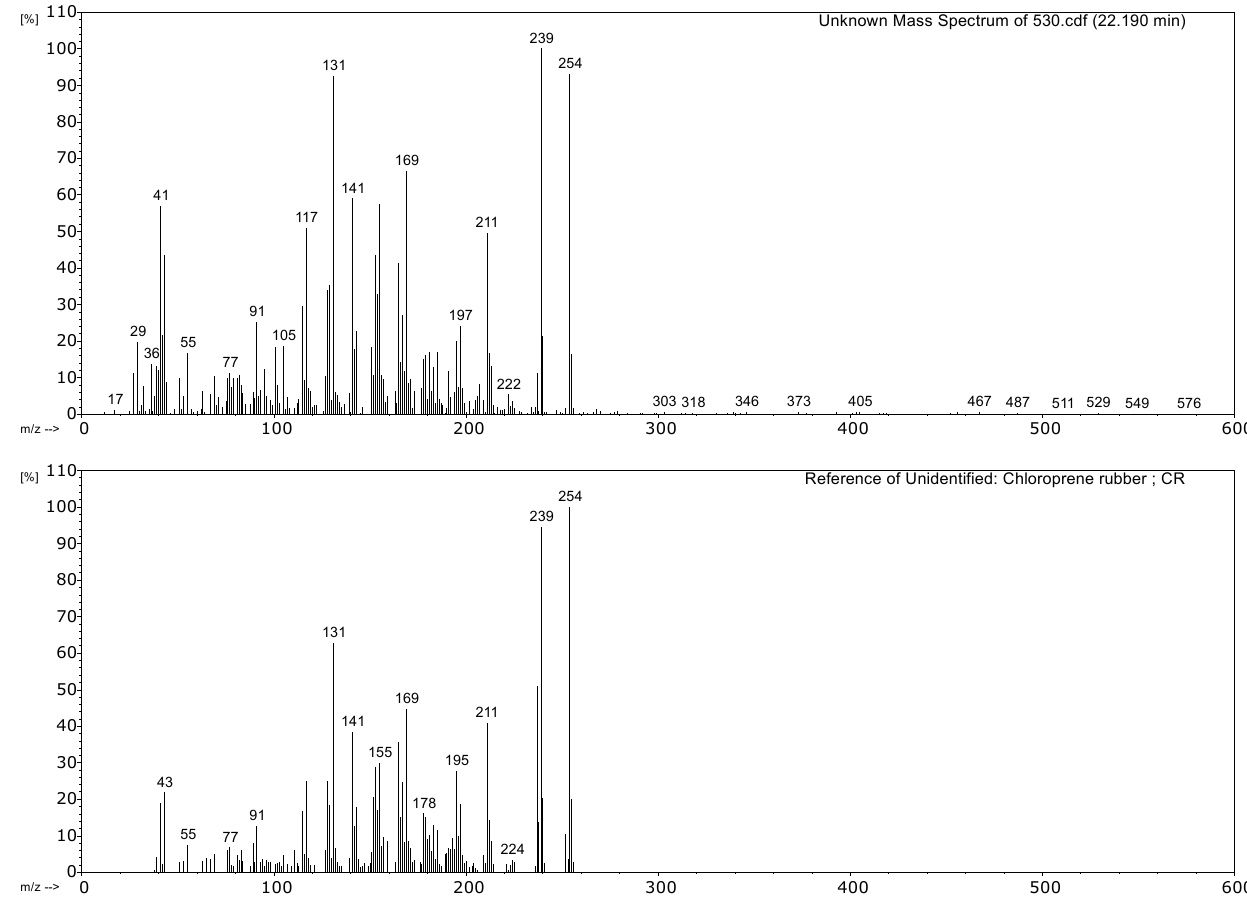
Figure 17. Mass spectrum of peak eluting at 22.19 min in the pyrogram of sample 530, along with a reference spectrum (F ‐ Search database).